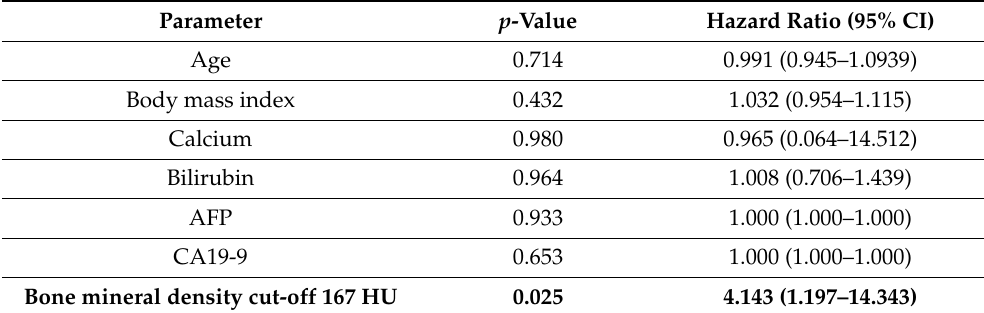
Table 3. Multivariate Cox regression analysis for the prediction of overall survival.